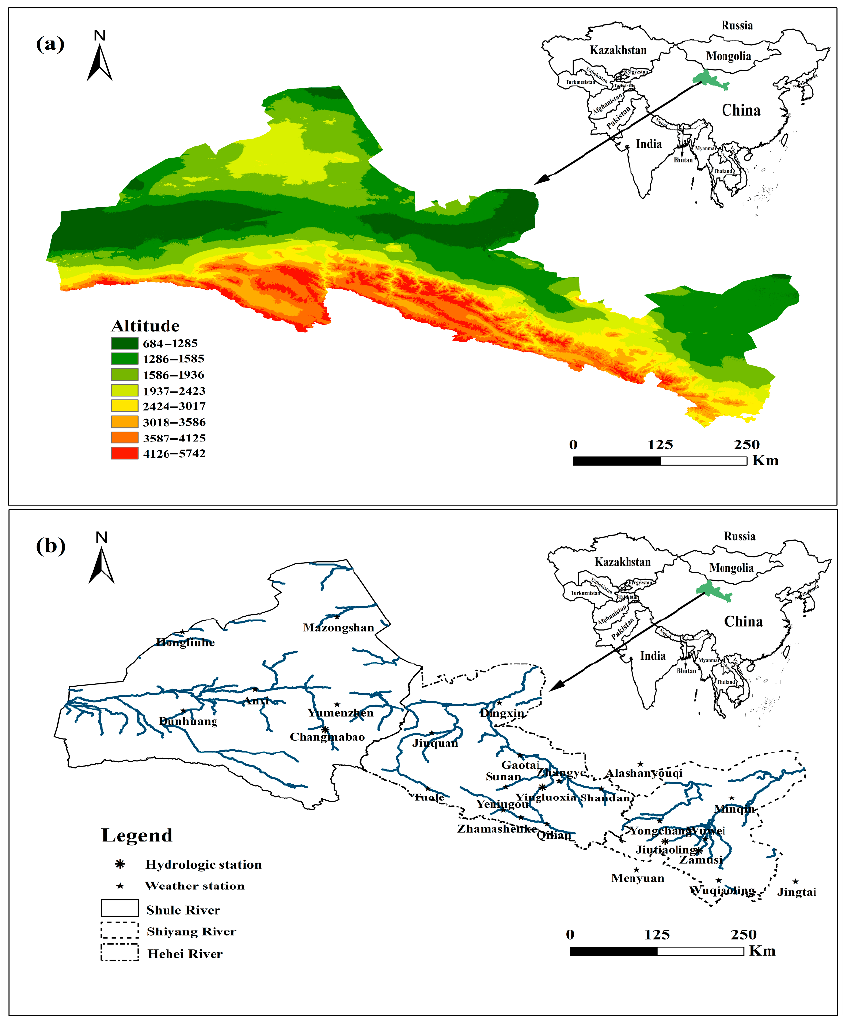
Figure 1. Overview of the Hexi inland rivers basin: ( a ) the elevation; ( b ) the river network, catchment area, and the observational stations.